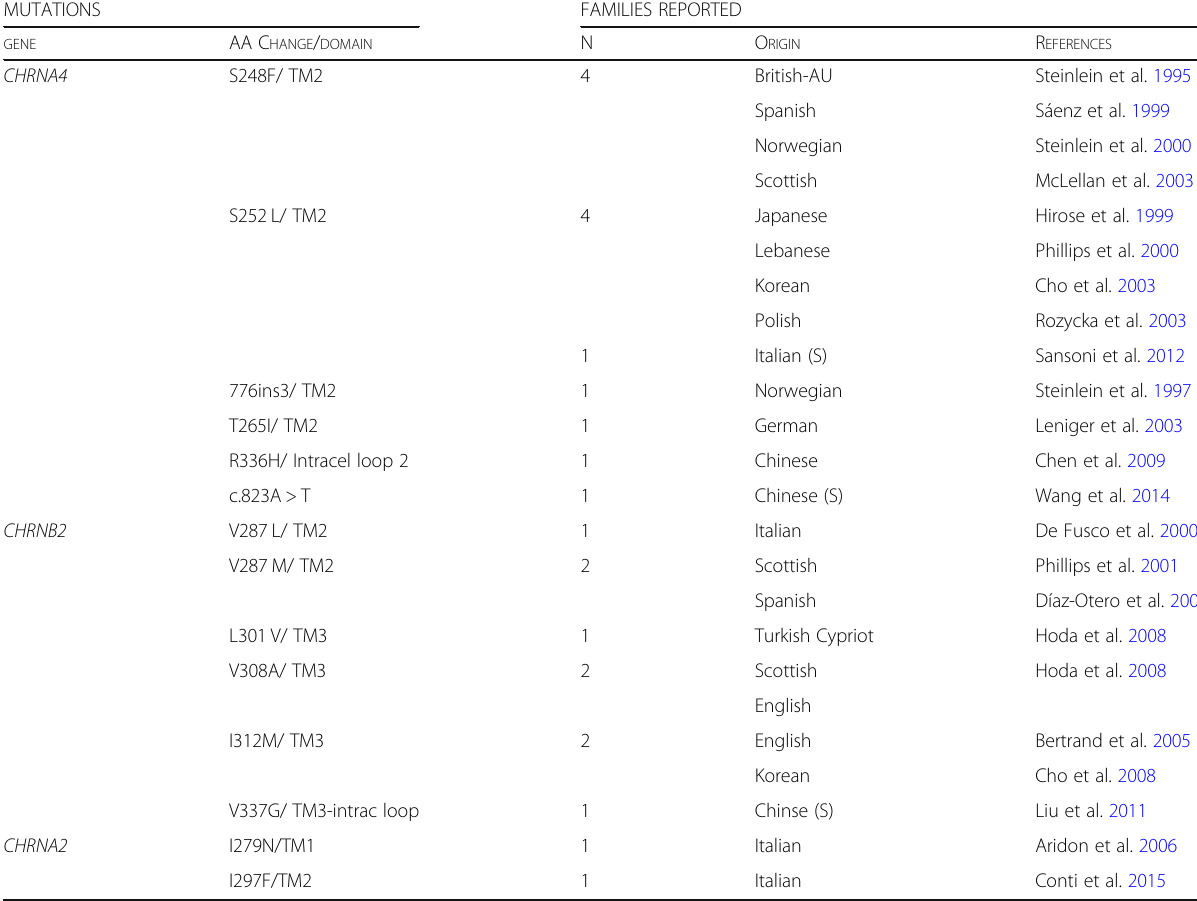
Table 1 Families and sporadic cases with mutations in CHRNA4 , CHRNB2 and CHRNA2 reported so far MUTATIONS FAMILIES